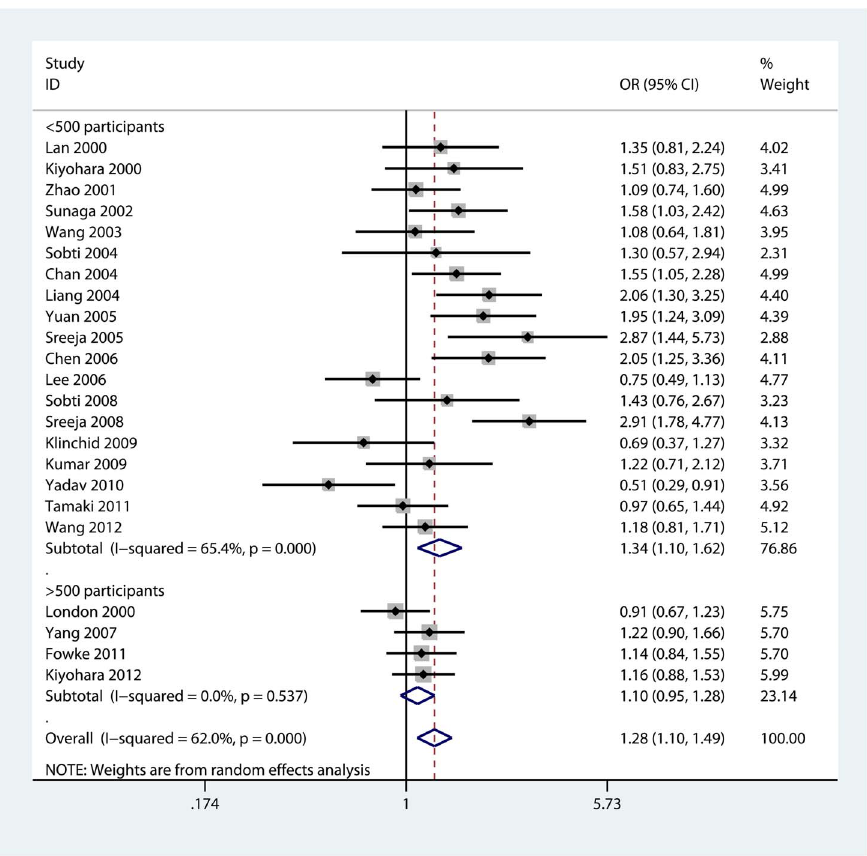
Figure 2. Forest plot for the association between GSTT1 null genotype and lung cancer risk in Asian population on stratification by sample size.